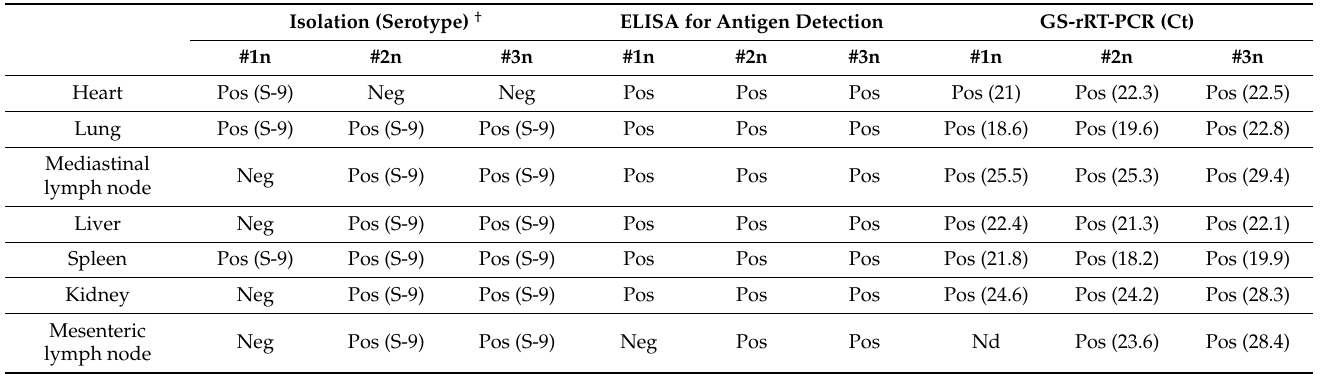
Table 5. Comparative AHSV detection in organs of unvaccinated horses (#1n, #2n, and #3n).